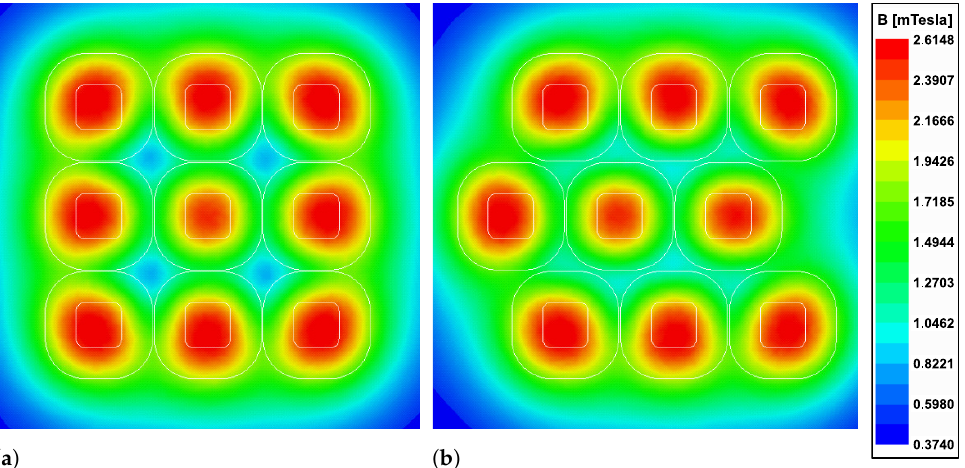
Figure 5. Magnetic flux density on the area of 300 mm × 300 mm at 20 mm above the 9-coil array with ( a ) straight configuration, ( b ) zigzag